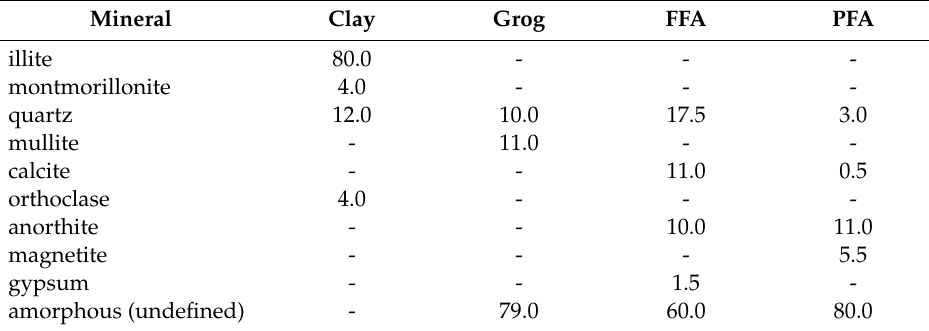
Table 2. The mineral composition of input materials (in mass%).